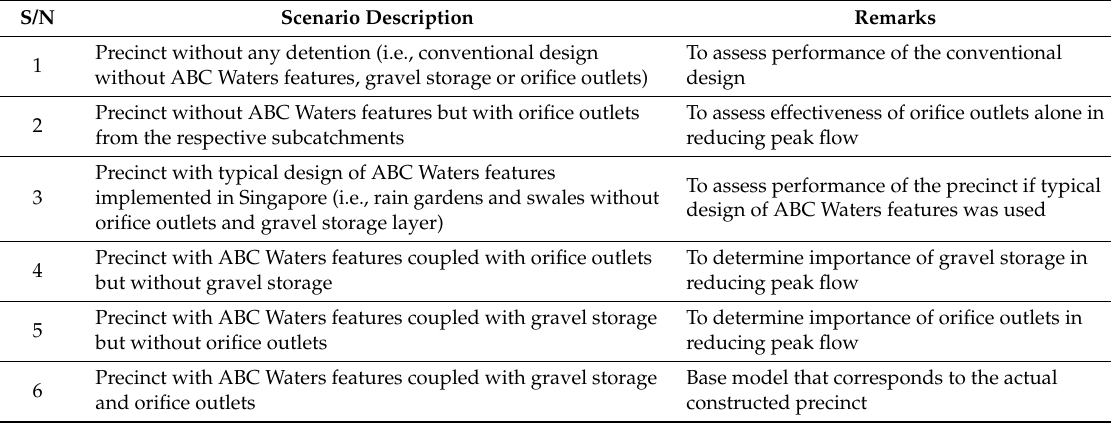
Table 1. Summary of base and alternative scenarios of the precinct which were modelled and analysed. S/N Scenario